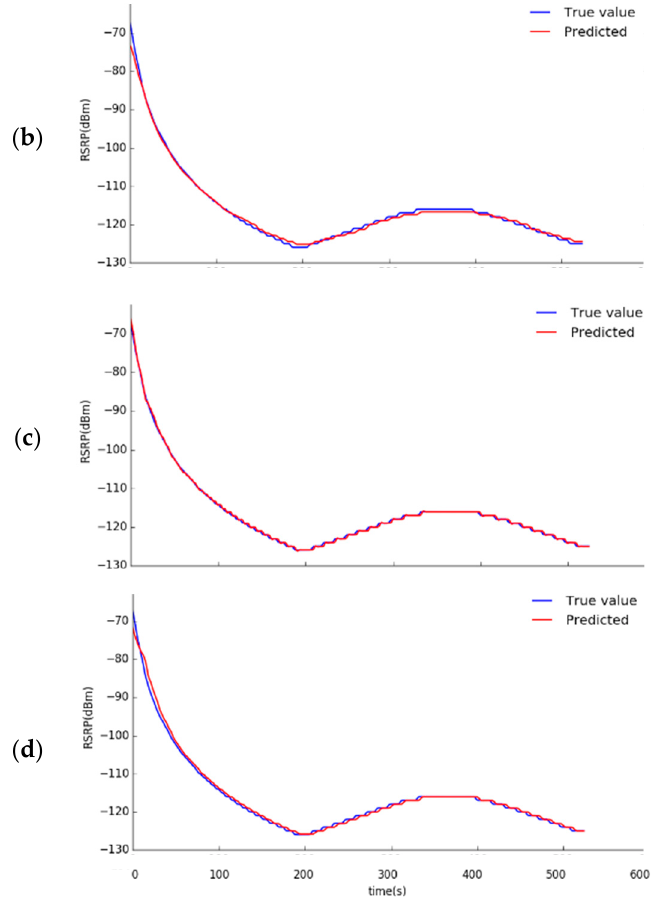
Figure 15. Predicted RSRP results for the next 2 s: ( a ) MLP, ( b ) CNN, ( c ) RNN, ( d ) LSTM.